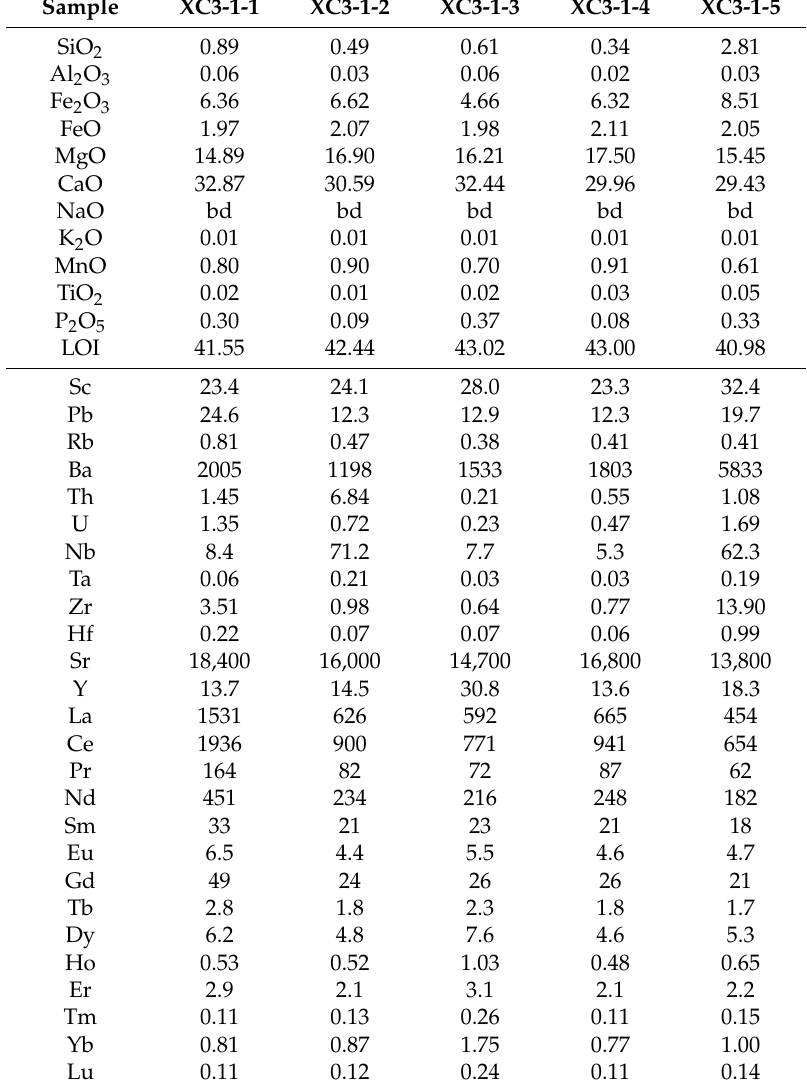
Table 1. Major element (wt.%) and trace element (ppm) concentrations of rock samples from the